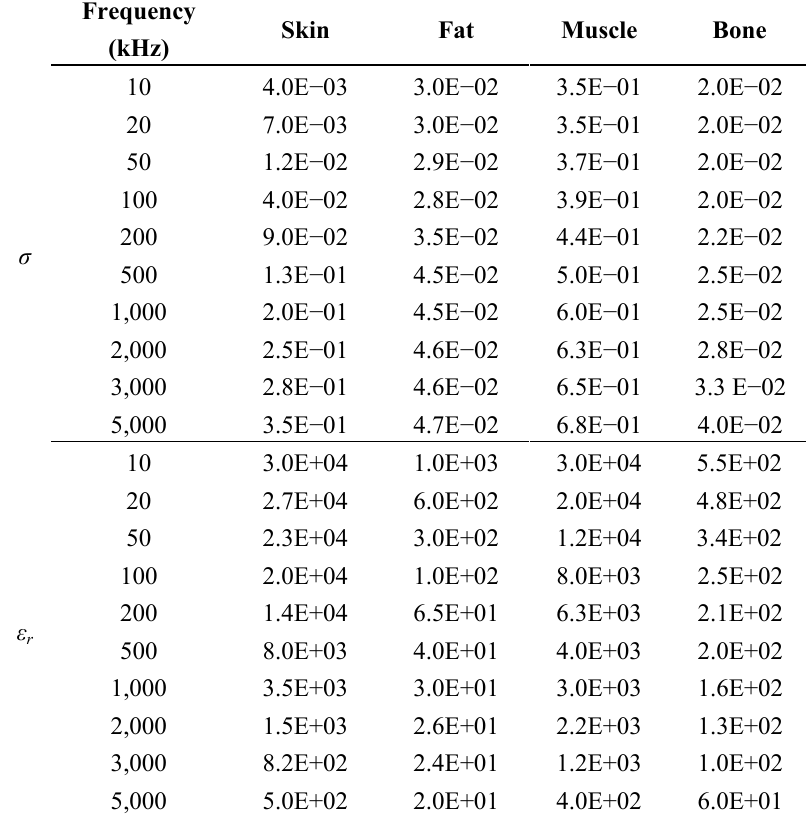
Table 1. The conductivities and relative